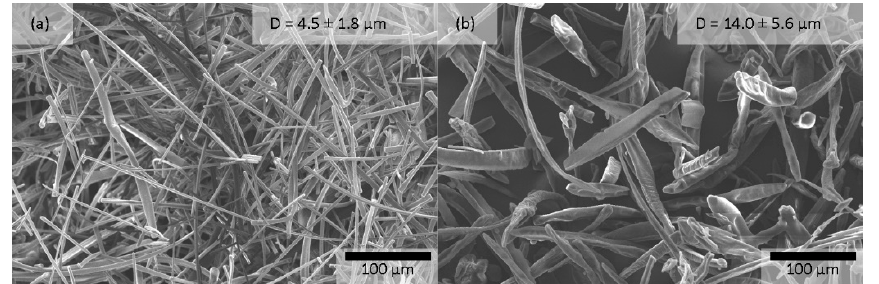
Figure 3. HP β CD–ASO1 formulations produced by pilot-scale HSES equipment from ( a ) water and ( b ) methanol/water (10:1). The electrospinning parameters are summarized in Table 2.